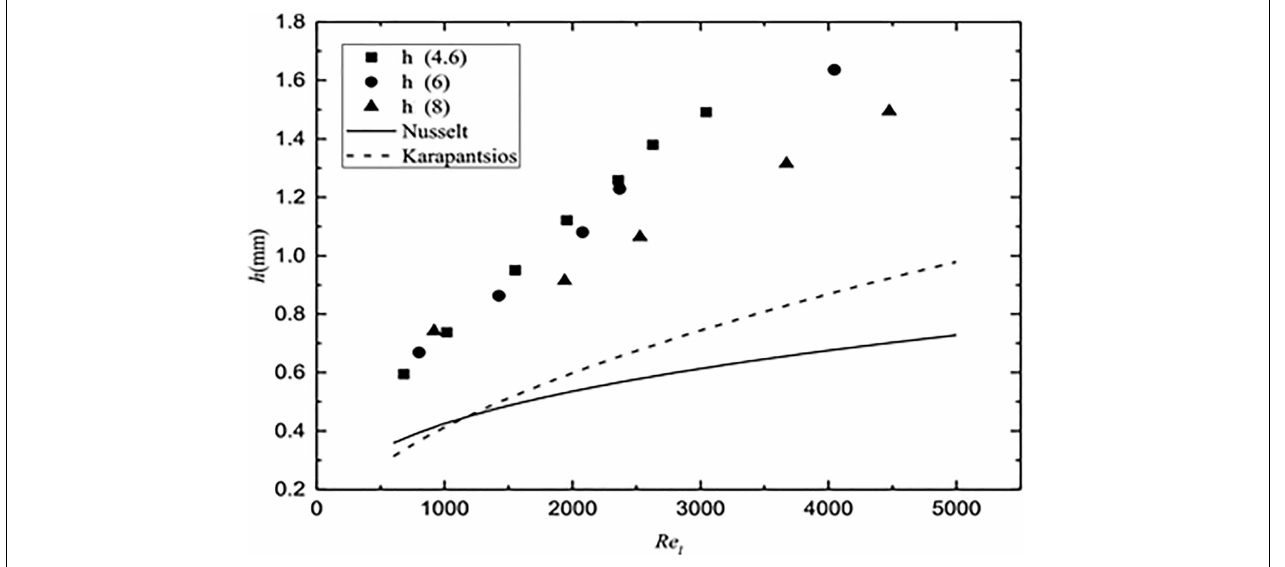
FIGURE 5 | Curve of average thickness of liquid film with Reynolds number.